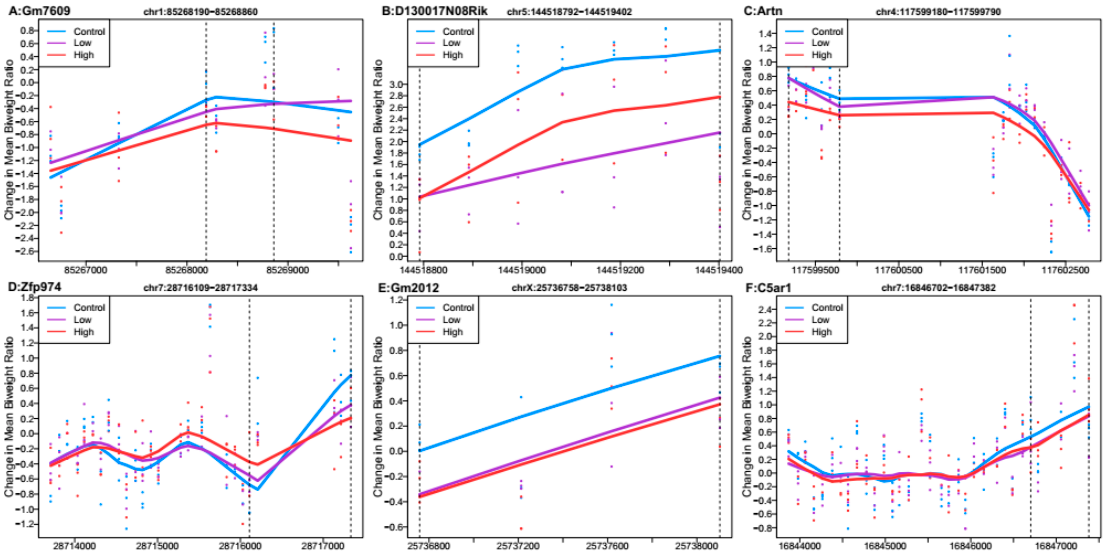
Figure 1. Differentially methylated regions associated with high perinatal Pb exposure (32 ppm) relative to controls. Top hits reaching Stouffer < 0.5. Regions within dashed lines indicate the differentially methylated region. The area outside the boundary are plotted to show trends outside the region. Nearest gene to regions: ( A ) Predicted pseudogene 7609 ( Gm7609 ), chromosome 1:85268190-85268860. ( B ) RIKEN cDNA D130017N08 gene ( D130017N08Rik ), chromosome 5:144518792-144519402. ( C ) Artemin ( Artn ), chromosome 4:117599180-117599790. ( D ) Zinc finger protein 974 ( Zfp974 ), chromosome 7:28716109-28717334. ( E ) Predicted gene 2012 ( Gm2012 ), chromosome X:25736758-25738103. ( F ) Complement component 5a receptor 1 ( C5ar1 ), chromosome 7:16846702-16847382.